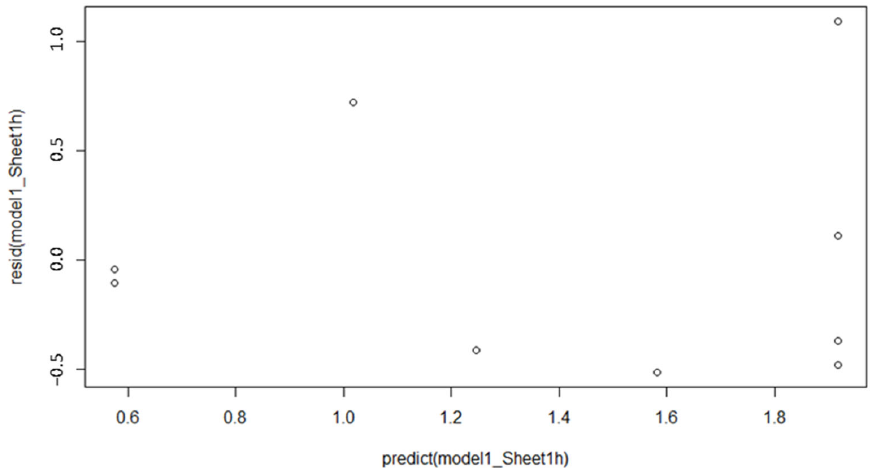
Figure 4. Plot of the residuals against the dust concentration values predicted by the model for the dust sheet test 1 h.